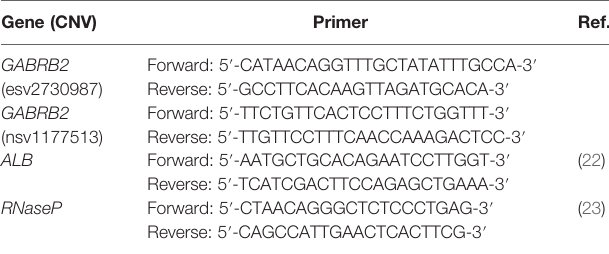
TABLE 1 | Primer sequences for measuring copy number status by